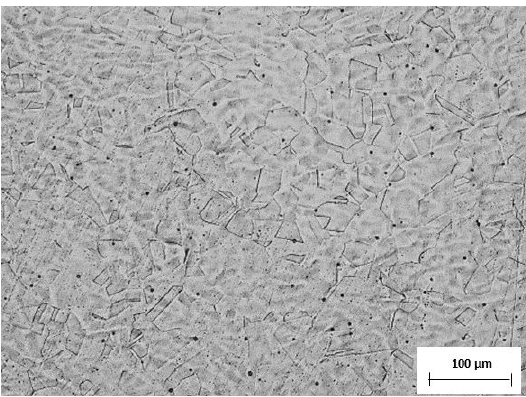
Figure 2. Cross section micrograph of the UNS S31266 sample after